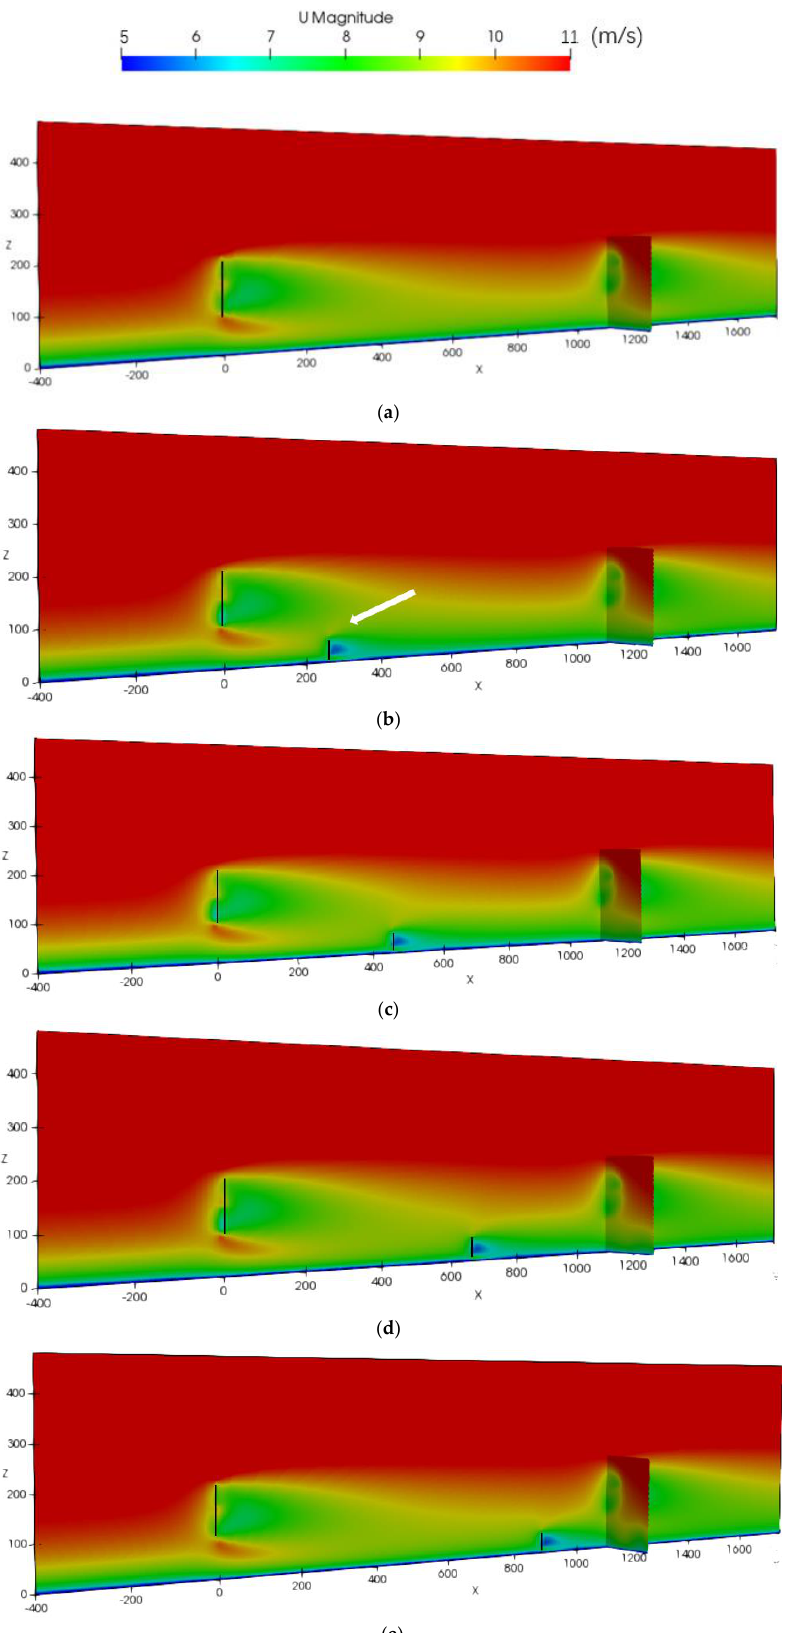
Figure 8. Streamwise mean velocity in the YZ and XZ planes. ( a ) Case 0. ( b ) Case 1. ( c ) Case 2. ( d ) Case 3. ( e ) Case 4.